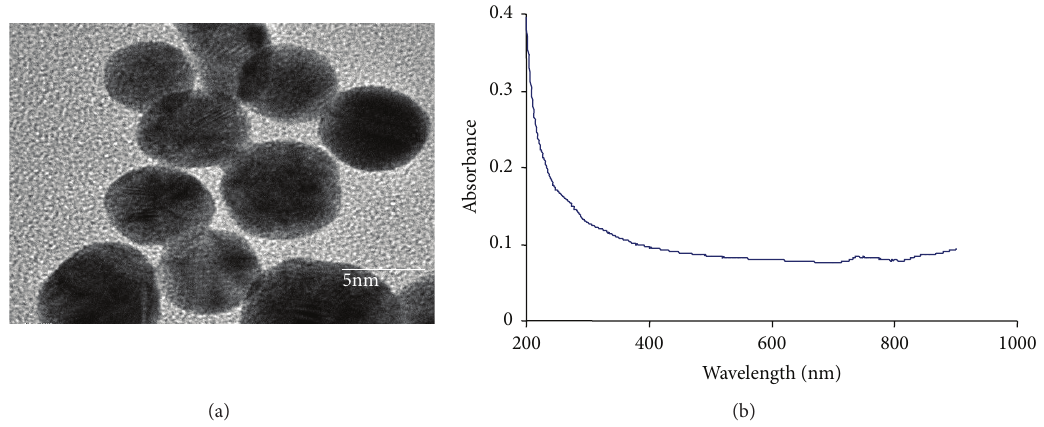
Figure 2: (a) Transmission electron micrograph of iron-oxide nanoparticles. Bar denotes 5nm. (b) UV-visible spectrum of iron-oxide nano- particles [23].